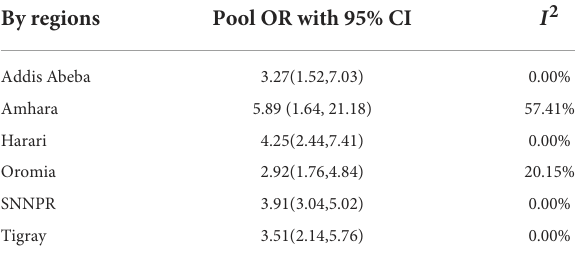
TABLE 5 Sub-group analysis of obstetrics emergency based on region of studies in Ethiopia from 2010 to 2022. By